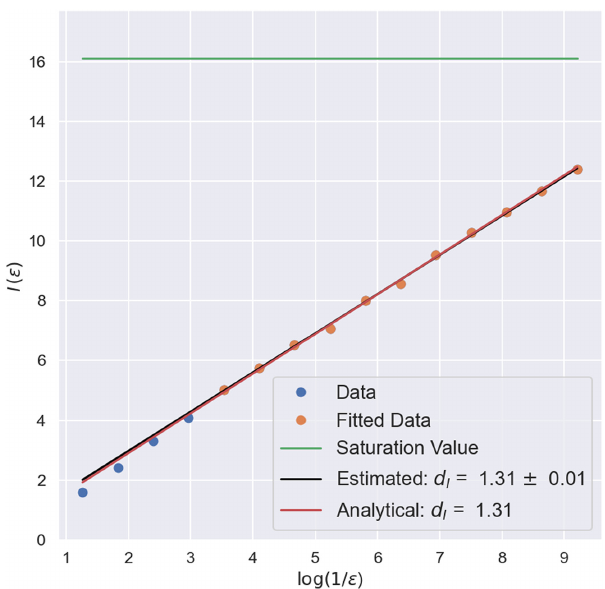
FIG. 4. Extended Baker’s map information dimension d I : the estimation incrementally decreases the coarse-graining scale (cid:11) and, at each step, calculates H ( Z (cid:11) ) . Then, excluding initial points to avoid saturation, it performs a least-square fit to extract the growth rate of H ( Z (cid:11) ) as a function of log ( 1 /(cid:11)) . We estimate d I = 1.31 ± 0.01. This is fully consistent with the analytical prediction of d I = 1.31, plotted in red. See Eq. (13) and Ref. [35] for the analytical